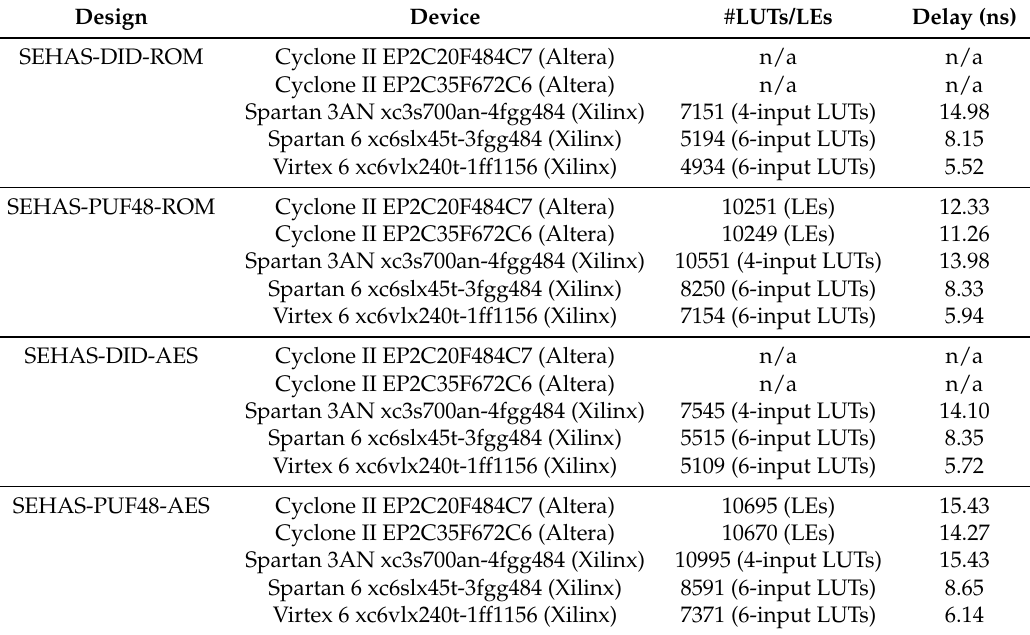
Table 3. Area and delay figures for SEHAS implementation on different